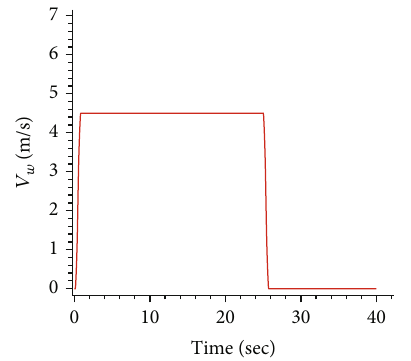
Figure 21: The discrete wind disturbance in fl ight simulation.